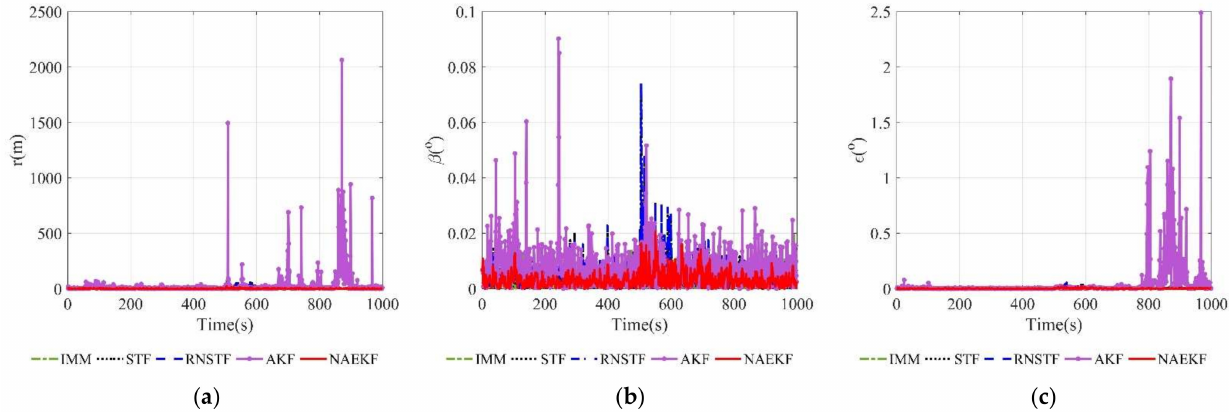
Figure 6. Position estimations errors. ( a ) Estimation errors of the range; ( b ) Estimation errors of the azimuth angle; ( c ) Estimation errors of THE elevation angle.